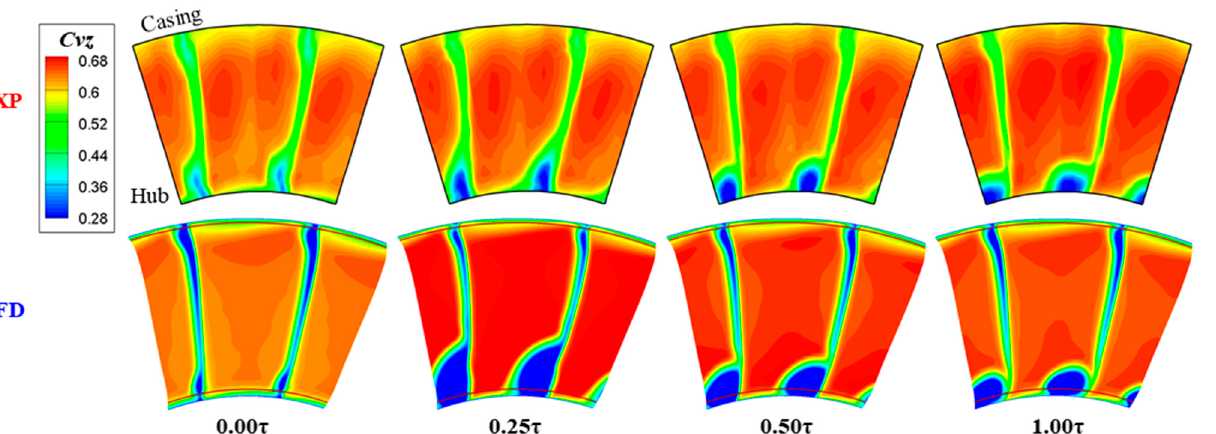
Figure 6. Limiting streamlines on the stator suction surface in the NS condition.